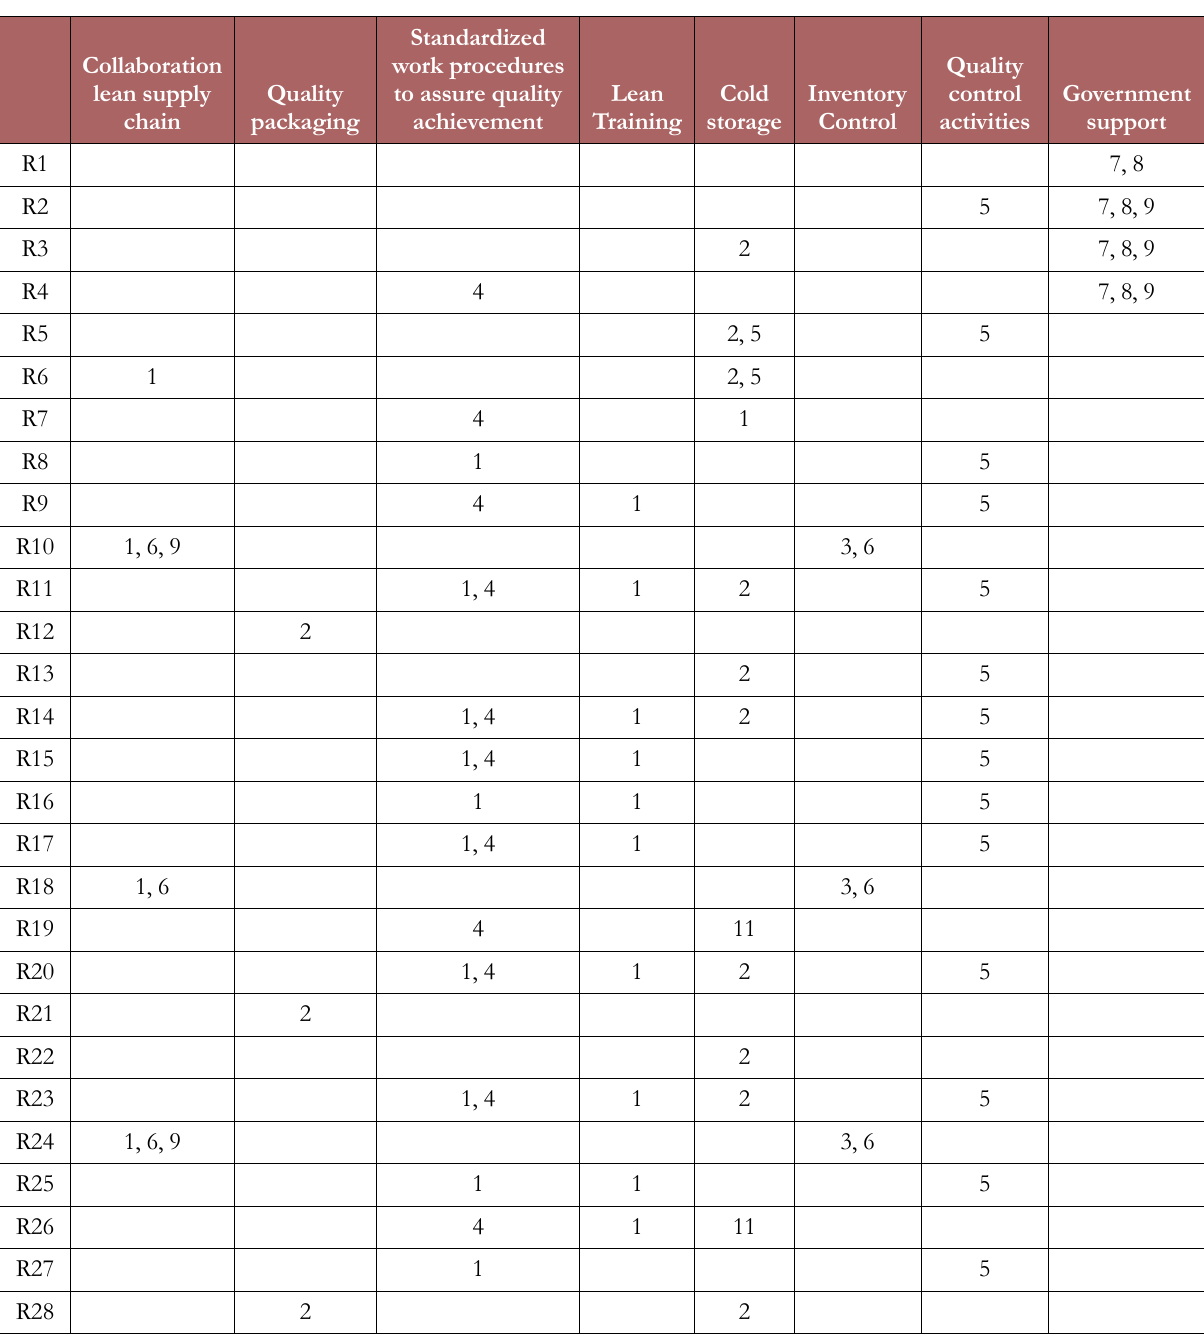
Table 5. Risk-lean relationship